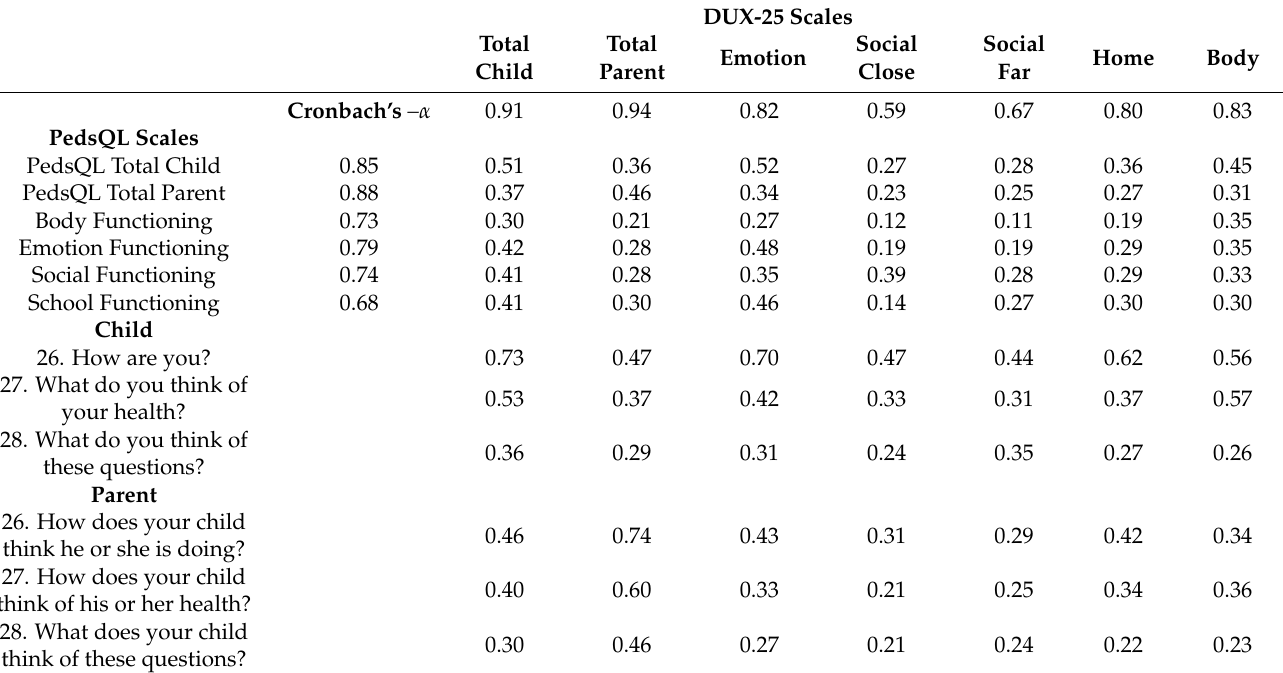
Table 4. Bivariate Correlations abcd between DUX-25 and PedsQL Scales.